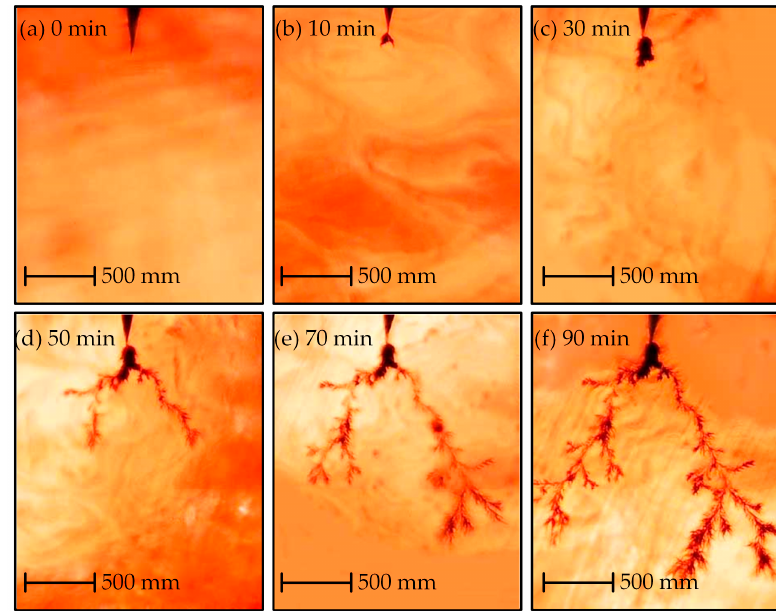
Figure 7. Growth characteristics of the electrical tree in sliced cable at 30 ◦